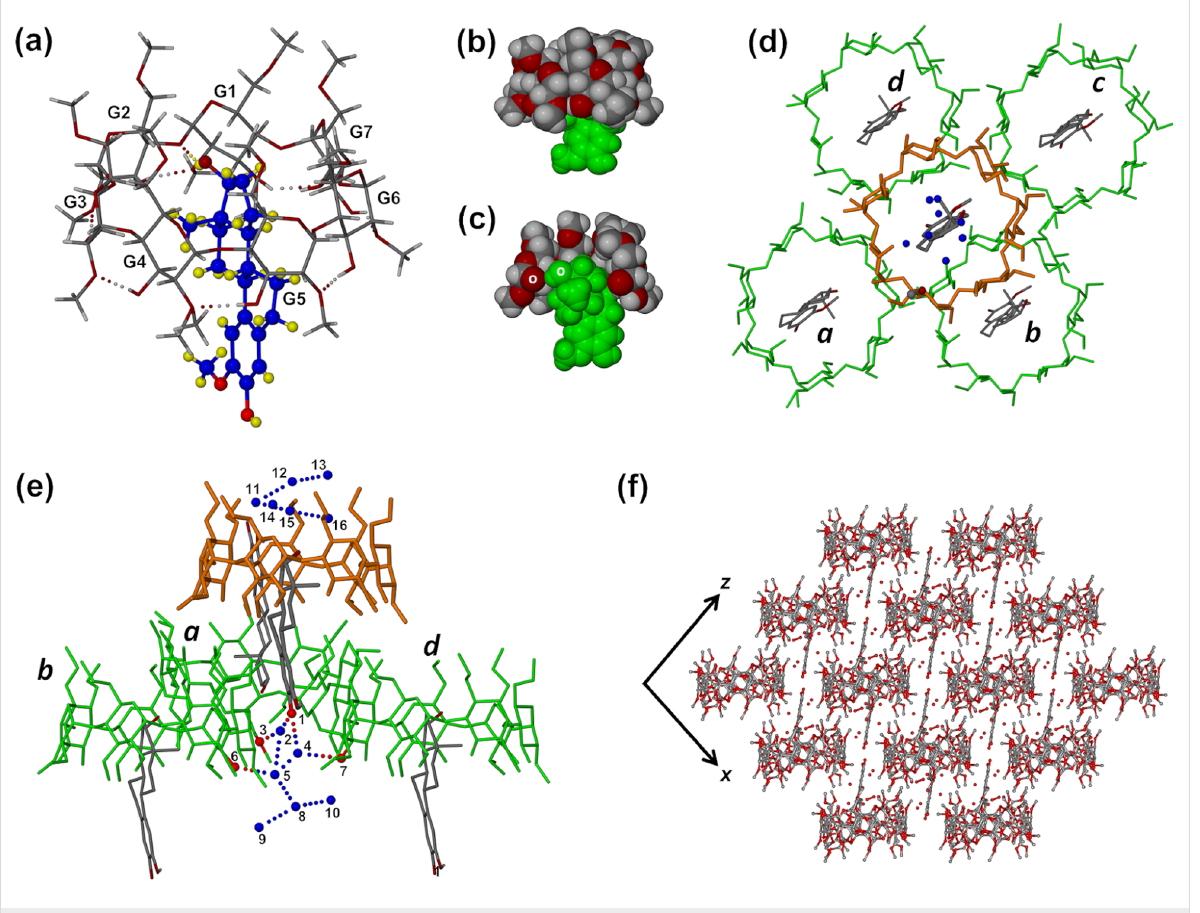
Figure 2: The mode of inclusion of 2ME in the DIMEB cavity (a), space-filling side view of the complex with the 2ME molecule in green (b) and cutaway view (c), location of the A-ring of 2ME protruding from the central DIMEB complex unit (orange) within the space created by the quartet of displaced neighbouring host molecules (d), H-bonding between the representative A-ring hydroxy group –O22–H and three neighbouring CD units mediated by water molecules (blue spheres) (e), and the extended packing arrangement viewed along [10] (f).